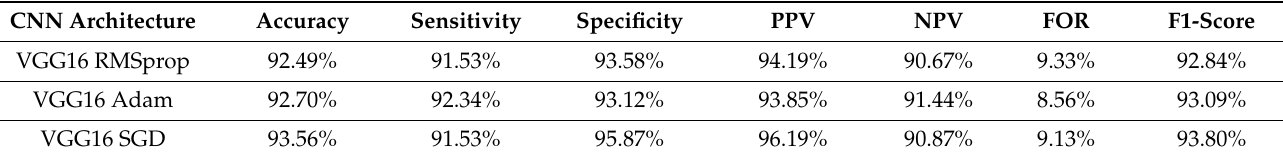
Table 7. Validation Statistical Analysis of the VGG16